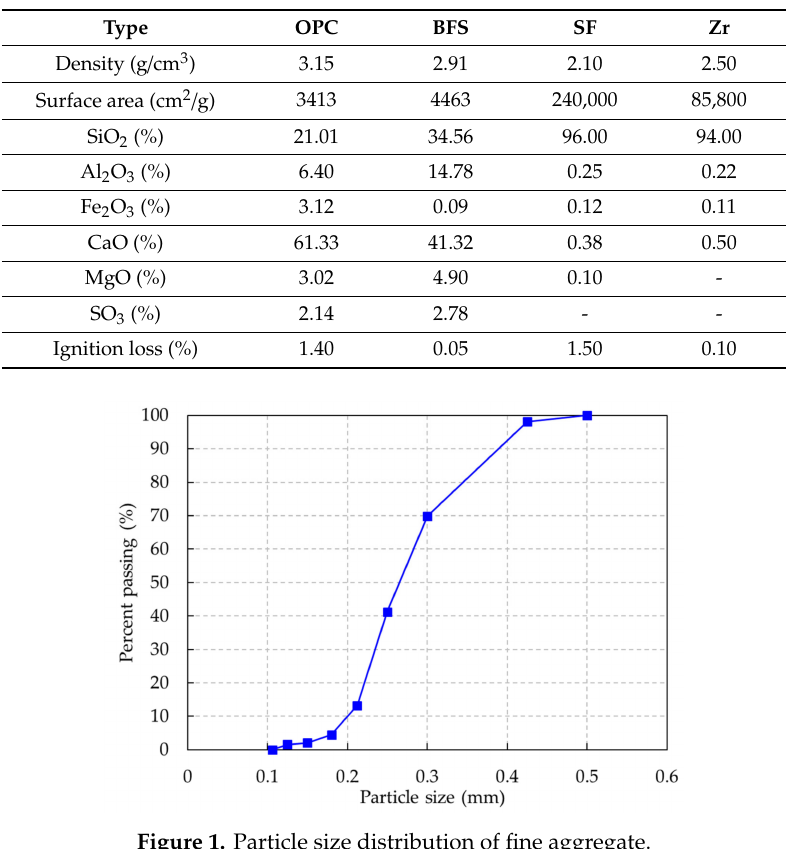
Table 2. Physical and chemical properties of binder materials.